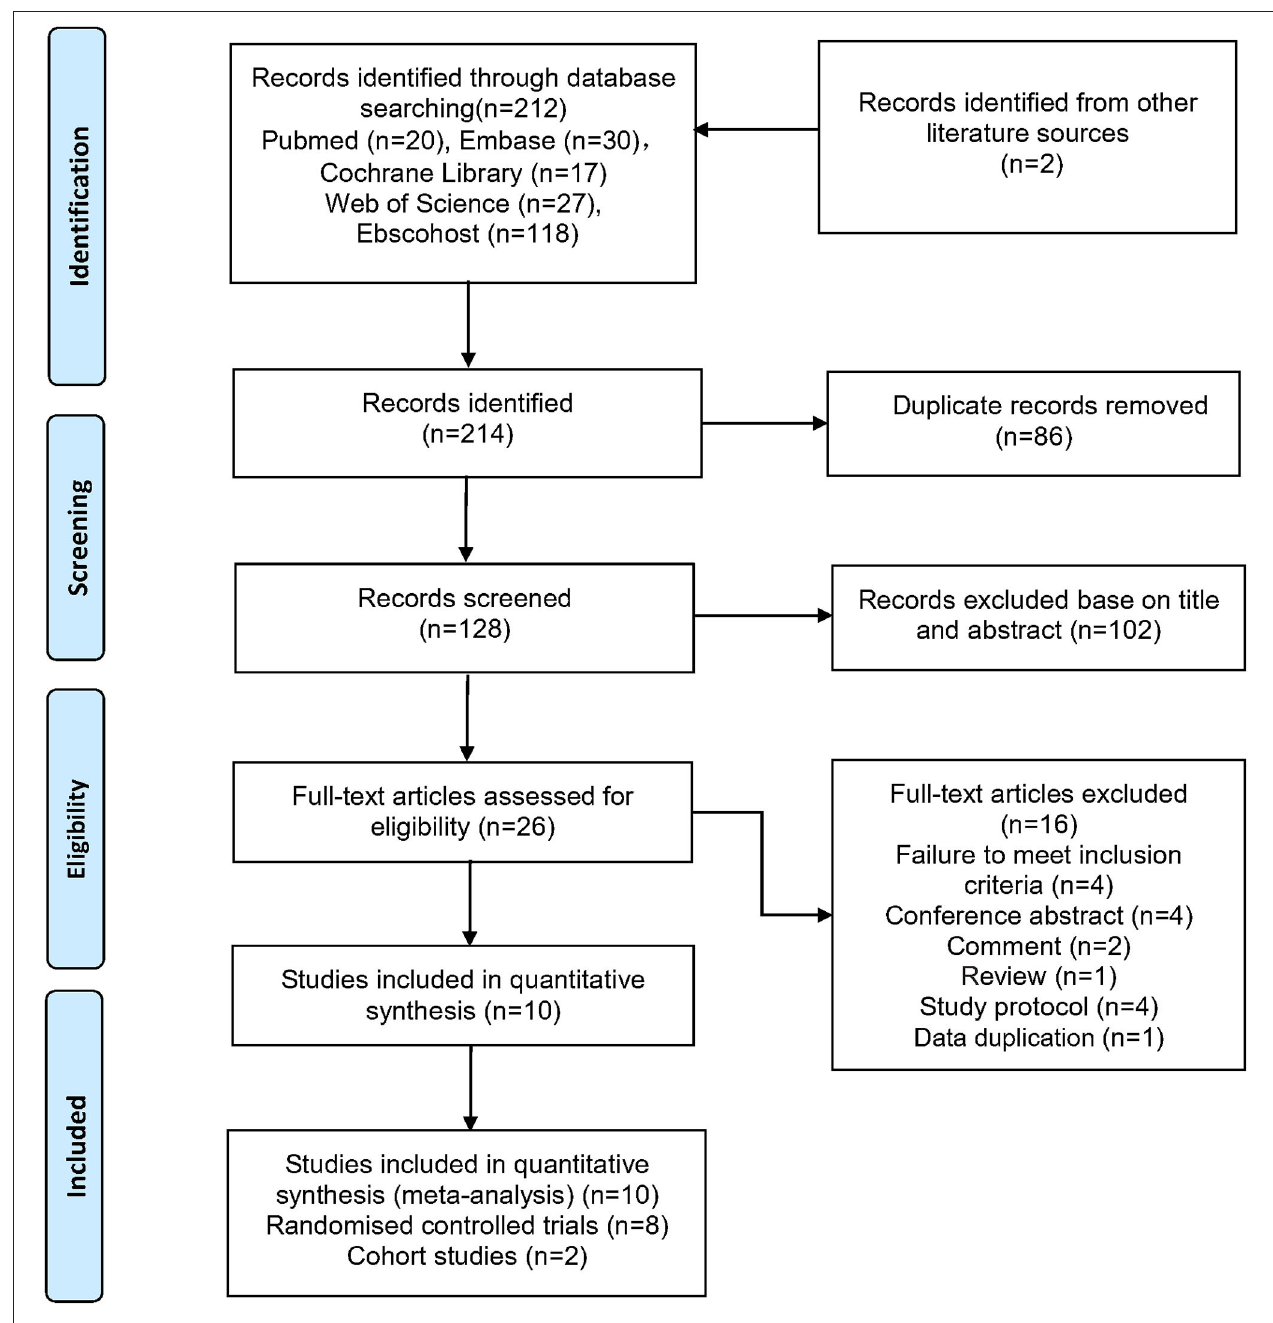
FIGURE 1 | Flow diagram of literature search and study selection.